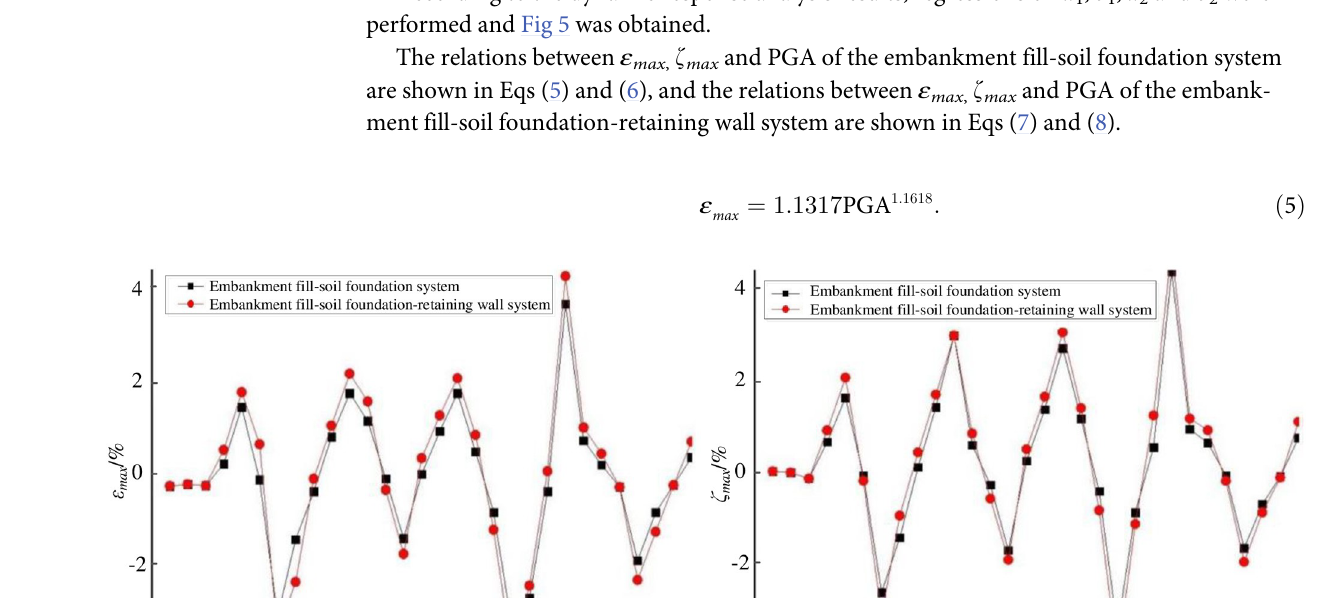
z and PGA of the embankment fill-soil foundation system max , max